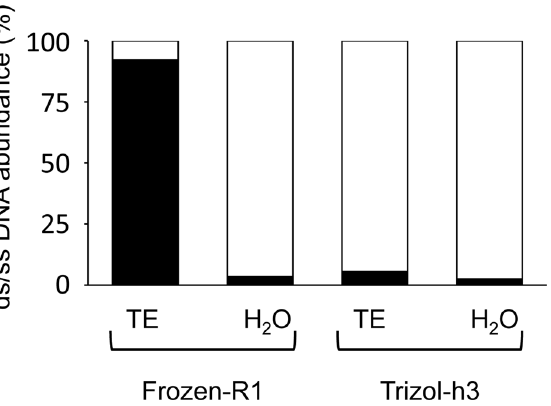
Fig 6. Quantification of ssDNA by ssDNA-Qubit and dsDNA-Qubit. Frozen-R1 and Trizol-h3 diluted with TE buffer or distilled water in 20 ng/ μ l were measured with ssDNA-Qubit and dsDNA-Qubit. The amounts of dsDNA (black) and ssDNA (white) were determined using the standard curve shown in S1